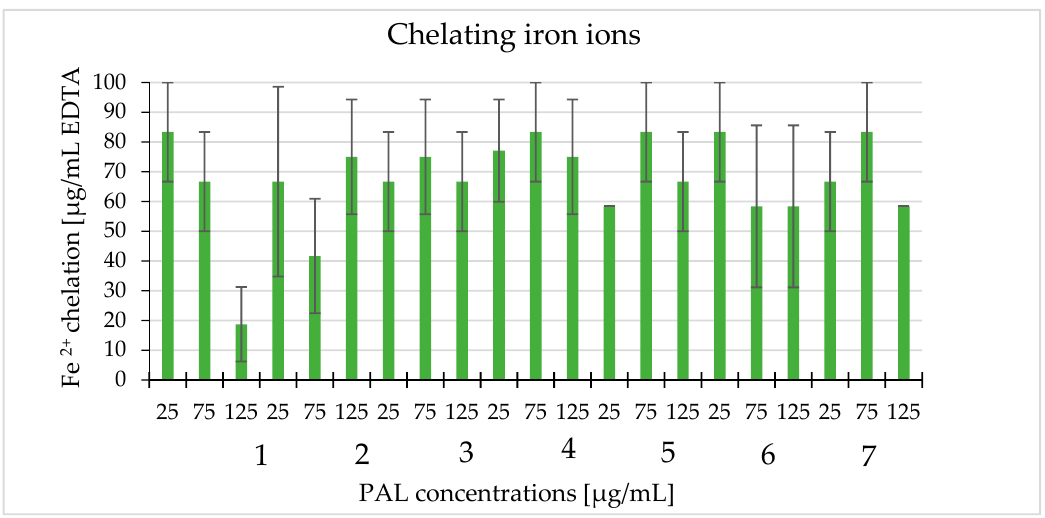
Figure 7. The ability of the tested extracts to chelate iron ions (PAL1–PAL7) at the concentrations 25, 75, and 125 μ g/mL expressed as EDTA equivalents ( μ g/mL).